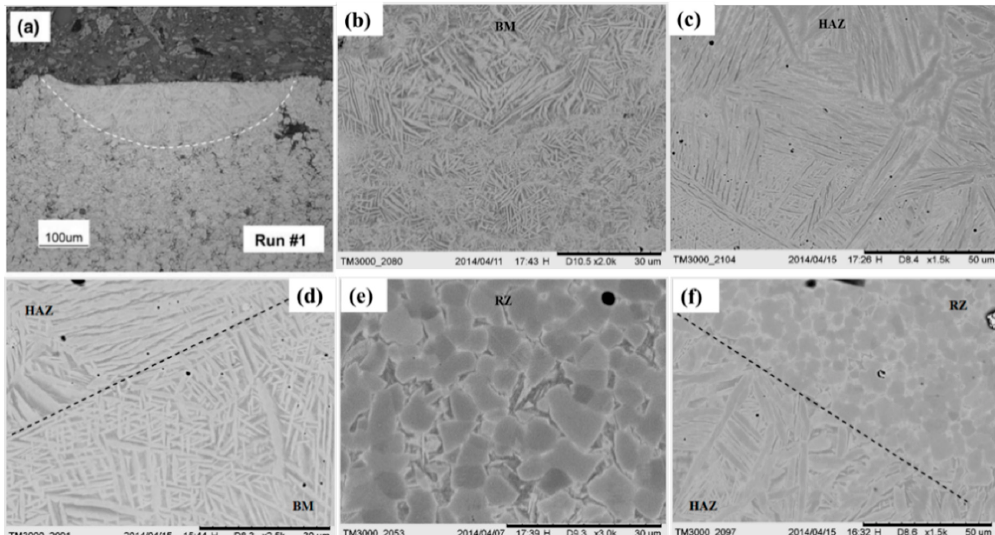
Figure 16. ( a ) Optical micrograph of the cross section of cold sprayed Ti coating after laser re-melting (adapted from reference [83] , with permission from © Springer Nature), and ( b – f ) SEM micrographs of cold sprayed Ti coating at different zones: ( b ) Base Material (BM); ( c ) Heat Affected Zone (HAZ); ( d ) transition zone between BM and HAZ; ( e ) Remelted Zone (RZ); and ( f ) transition zone between HAZ and RZ (adapted from [81] , with permission from © Elsevier).